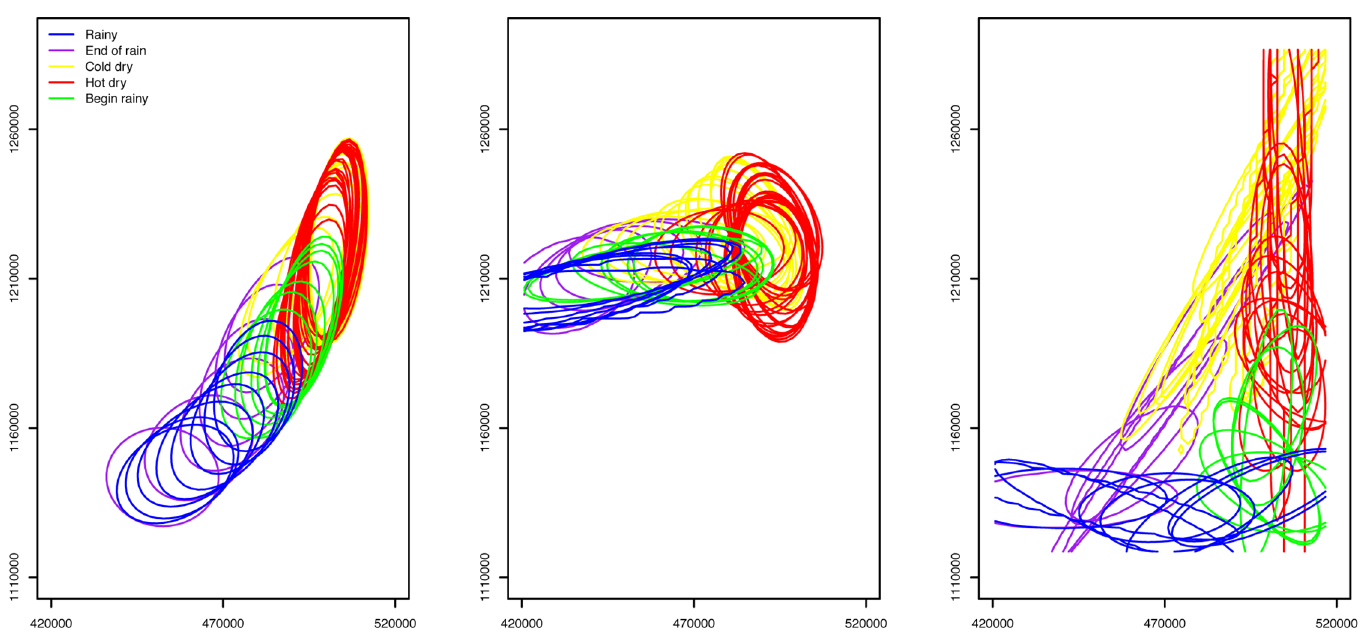
Fig 10. Results from the MVN model. Each contour encloses an area where G ( x t = x ) (cid:1) 95%. Each map shows the result after overlaying the contours of every 5 days throughout the year. Groups 1, 2, and 3 are represented in the figures from left to the right. The part of contours outside the study area is not shown in the